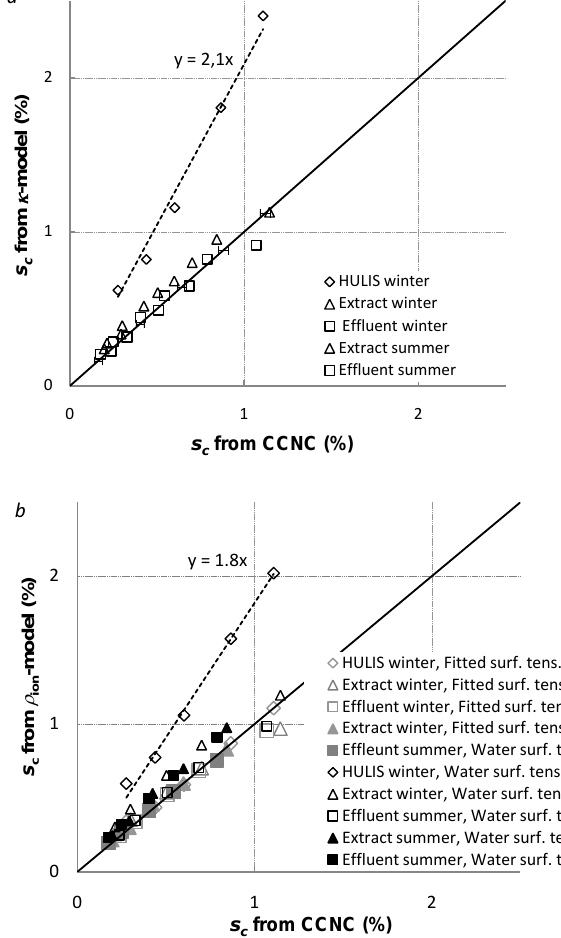
Fig. 7. Measured and modelled s c values for the SMOCC day and night samples based on the ρ ion model with water surface tension, using H-TDMA data as input. Due to the small amount of material in the sample, they were analysed either by the CCNC or the H- TDMA. Thus, the predicted s c values are based on data before and after the CCNC period. The lines represent the supersaturation ra- tios of three different arbitrary ideal compounds as a function of dry diameter, D p , and are intended solely to guide the eye on the ideal dependence of s c on D p . These s c values are calculated according to Eq. (4).